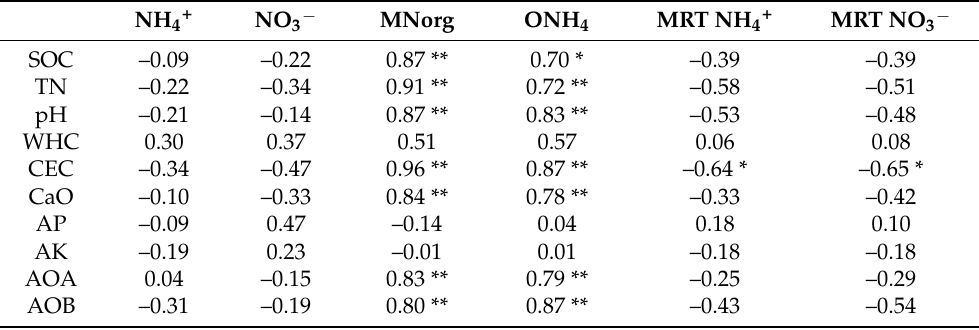
Table 2. The relationships between soil properties, gross mineralization (M Norg ) and nitrification (O Norg ) rates, and archaeal amoA gene (AOA) and bacterial amoA gene (AOB) abundances ( n = 12), under banana plantation